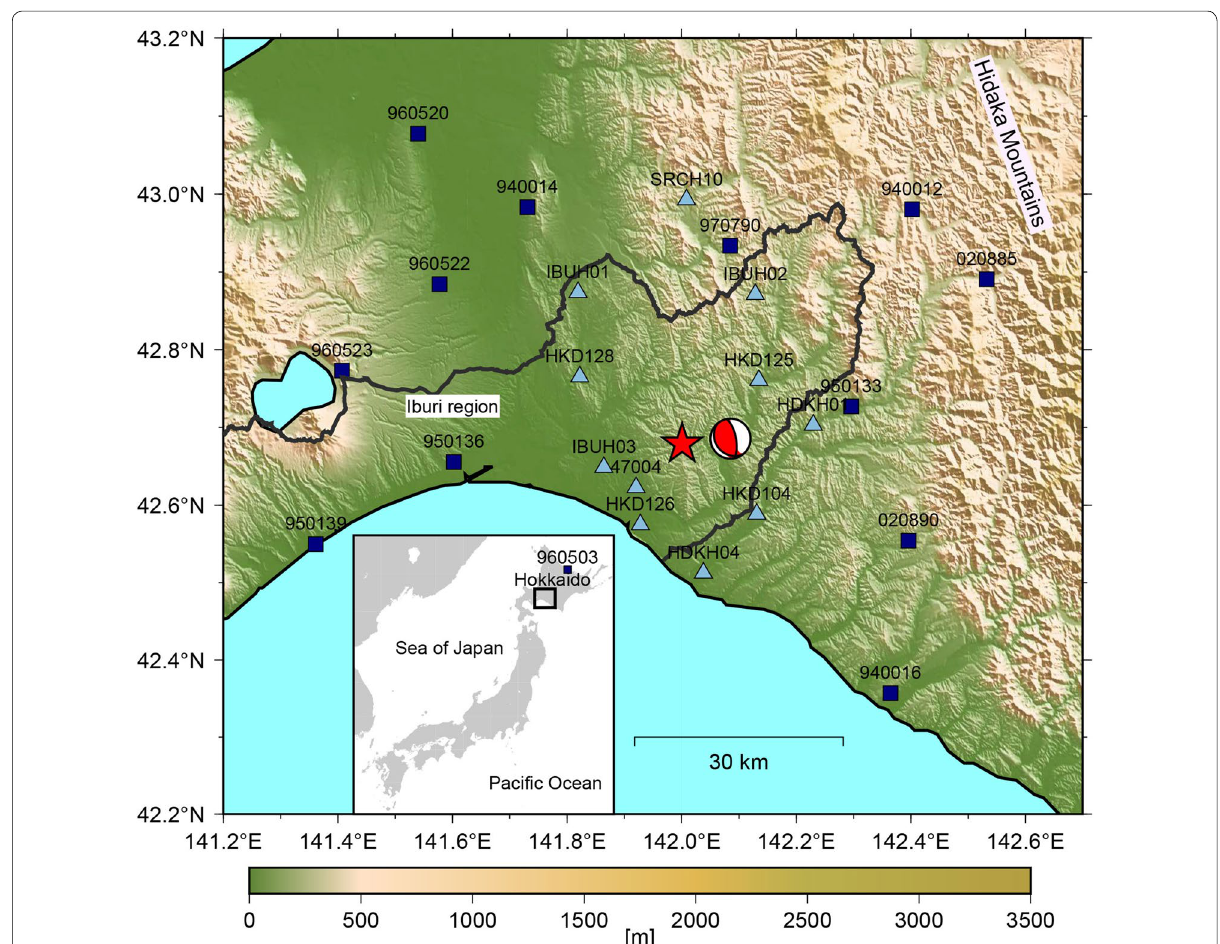
Fig. 1 Study area map. The black square in the inset map shows the map location. The dark gray line represents the boundary of the Iburi region. The red star denotes the relocated epicenter of the mainshock and the focal mechanism from the Global CMT solution is shown near the epicenter. The sky blue triangles represent the strong motion stations of K-NET, KiK-net and JMA. The dark blue squares indicate the GEONET stations. The background colors show the surface